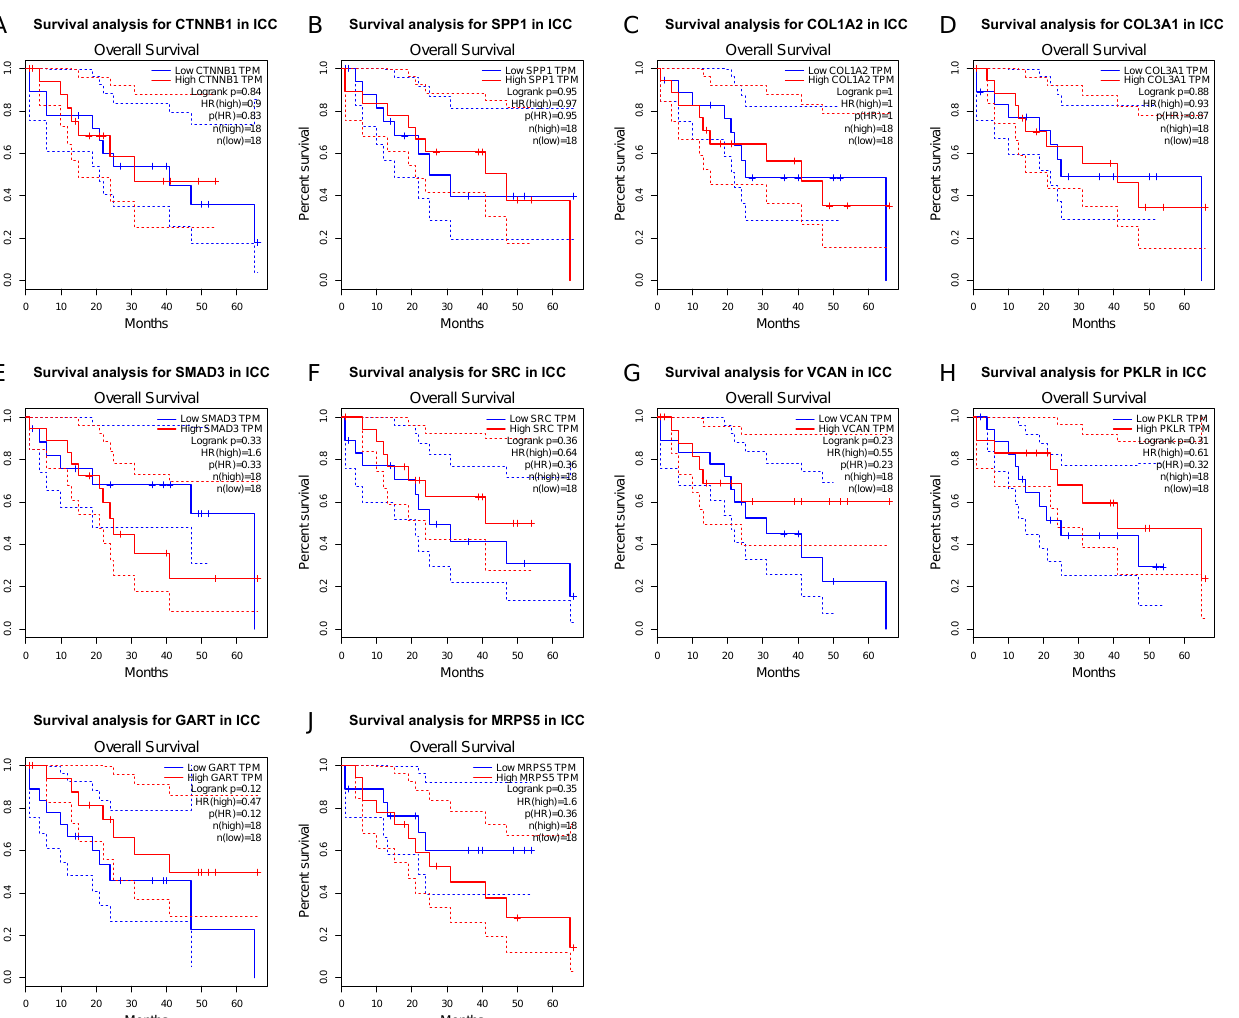
Figure 7. Kaplan–Meier curves of hub gene expression and overall survival for each of the top hub genes. Blue curve: low-expression group; red curve: high-expression group.